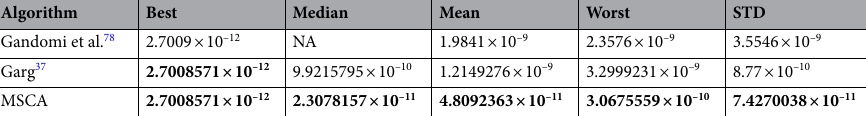
Table 20. Statistical result for gear train design problem. NA means not available. Significant values are in